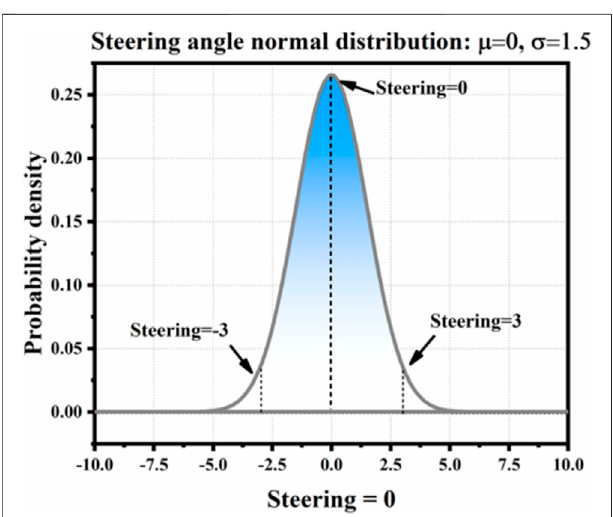
FIGURE 10 | Example of Gaussian distribution of the steering angle when going